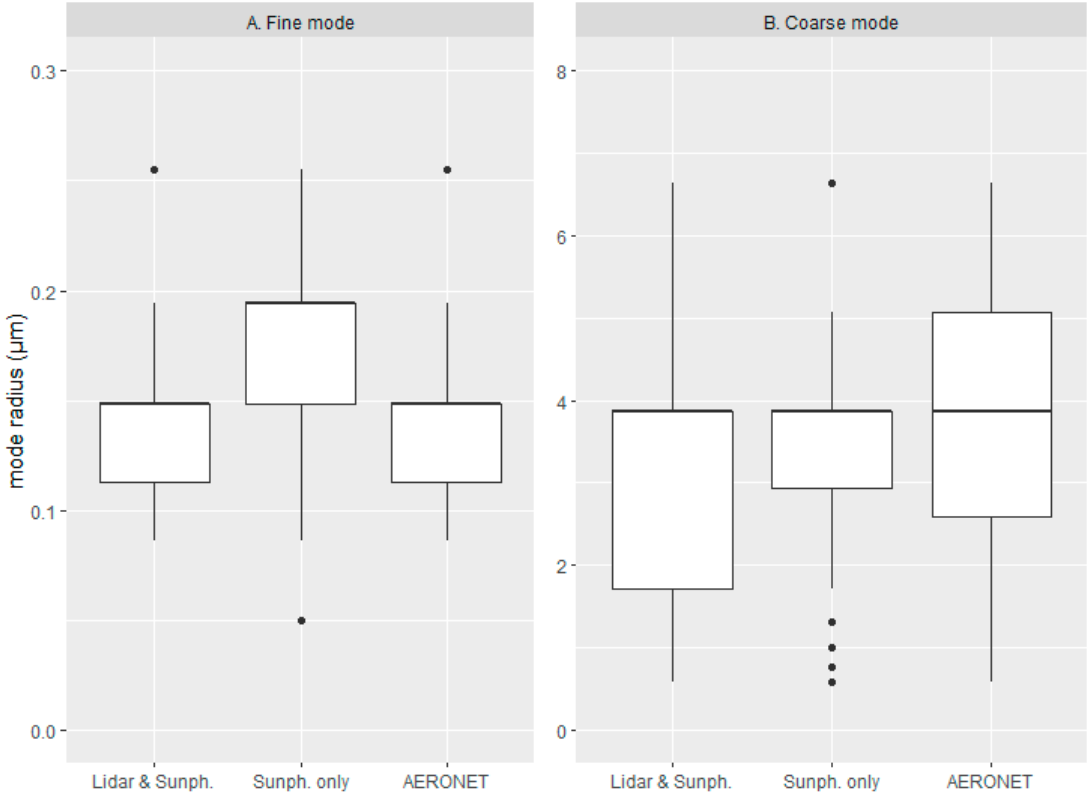
Figure 5. Boxplots of the mode radius for (A) fine and (B) coarse modes for the two different GRASP schemes (Scheme 1, labeled as Sunph. only. Scheme 2, labeled as Lidar & Sunph.) and AERONET.